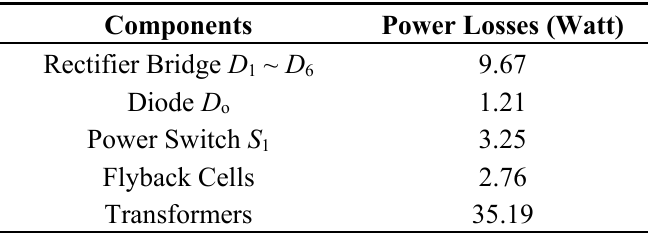
Table 4. Power losses summary.